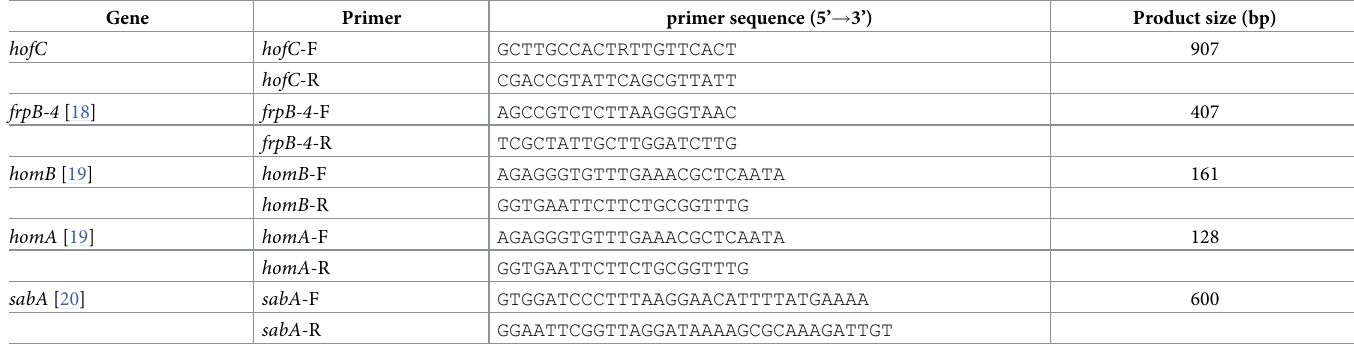
Table 1. Primers used for PCR amplification of hofC , frpB-4 , homB , homA , and sabA genes.